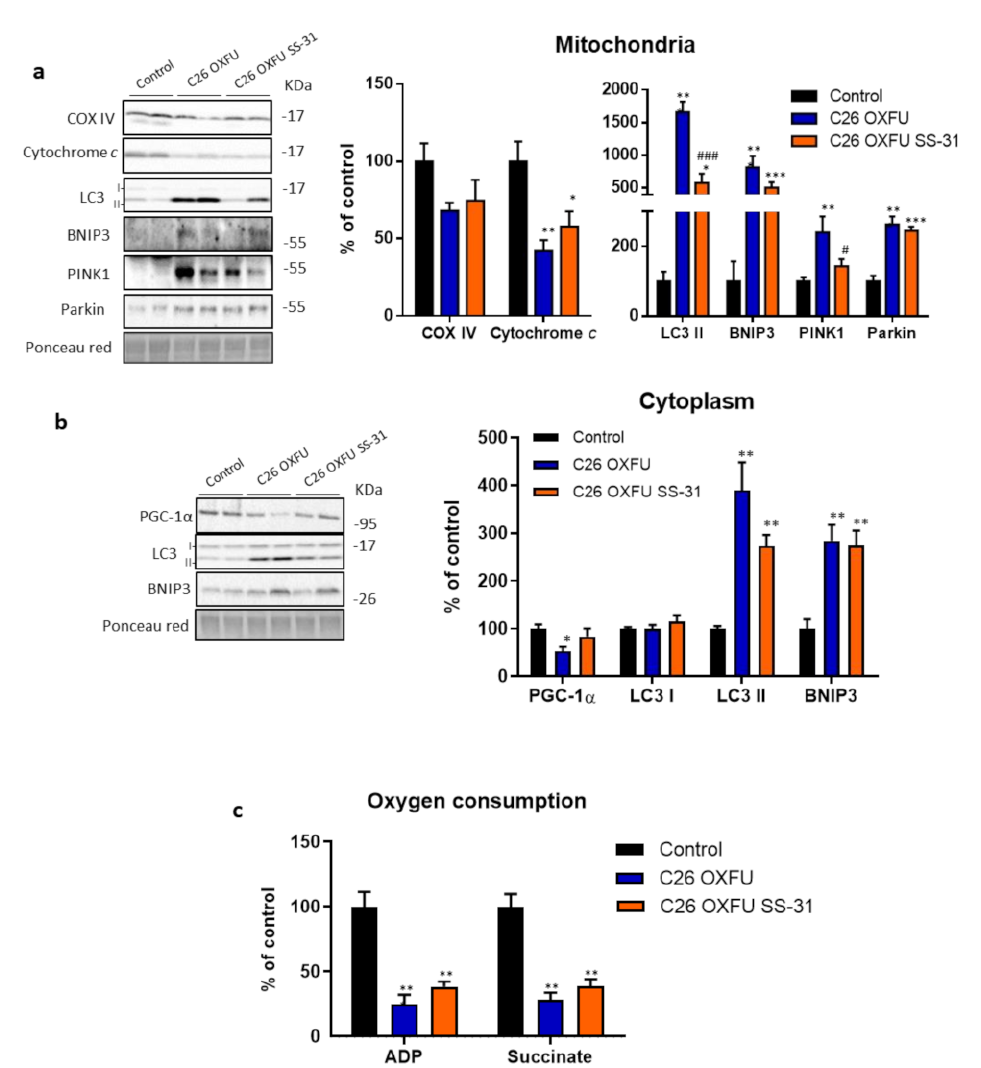
Figure 4. SS-31 counteracts mitochondrial loss and excessive autophagy/mitophagy. Mitochondria and au- tophagy/mitophagy marker proteins (representative blot and quantification) of mitochondrial ( a ) or cytoplasmic ( b ) fraction and ADP/succinate-coupled oxygen consumption ( c ) of controls ( n = 7) and tumor-bearing mice administered with chemotherapy alone (C26 OXFU; n = 8) or in combination with SS-31 (C26 OXFU SS-31; n = 8) at day 21 after tumor implantation. Protein and oxygen consumption data (means ± SEM) are expressed as percentage of control. Significance of the difference: * p < 0.05, ** p < 0.01, *** p < 0.001 vs. control; # p < 0.05, ### p < 0.001 vs. C26